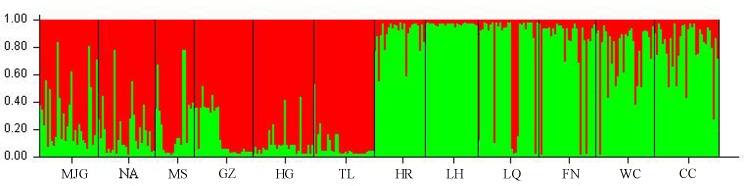
Bayesian STRUCTURE bar polt of membership for 12 C. mandshurica populations (K = 2).Red represents GroupsⅠand green represents GroupsⅡ. For details of locations abbreviations and locations, see Table 1 and Fig 1.